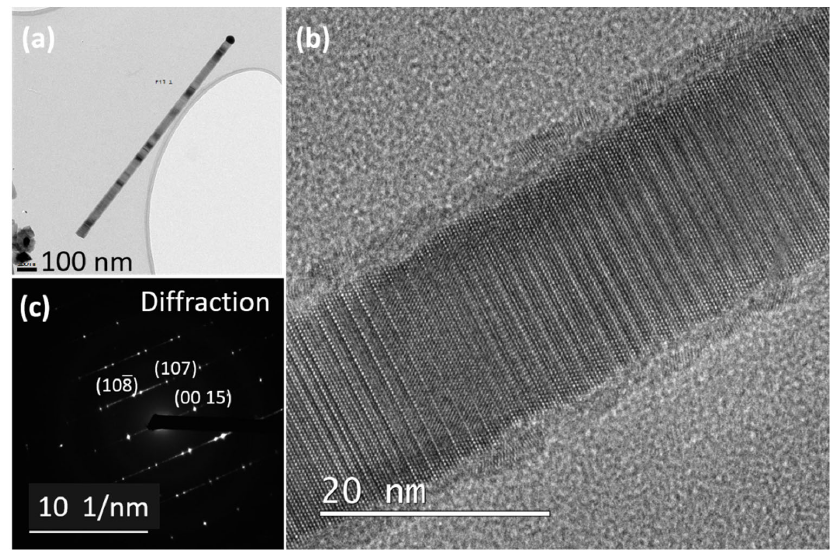
Figure 12. ( a ) Bright ‐ field TEM image of a single NW grown with lower supersaturation, ( b ) HRTEM image of NW revealing a 15R phase, and ( c ) SAED pattern of the NW shows a 15R footprint. In Figure 12b, the HRTEM image provides visuals of a 15R crystal phase stacking.